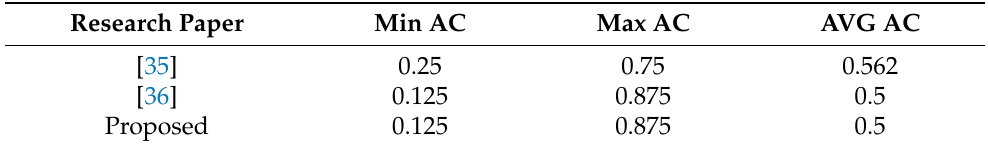
Table 8. Comparison between then proposed method and the previous works for the binary output of S-Boxes to compute balanced